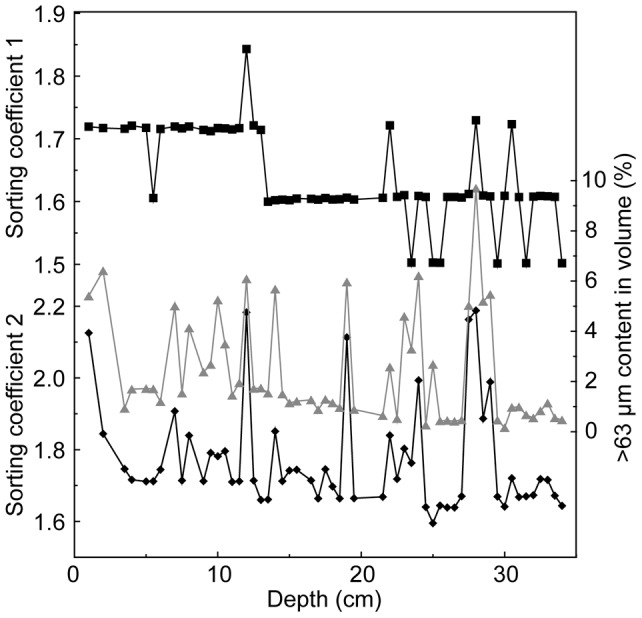
Comparison of sorting coefficients calculated using both Folk & Ward's (SC2) [16] and Trask's method (SC1) [15].The concentrations of >63 µm contents are given in volume.